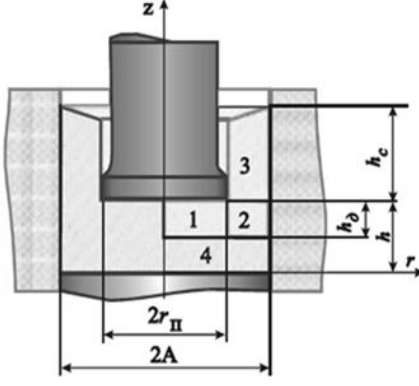
Fig. 3. Diagram of the process of radial extrusion